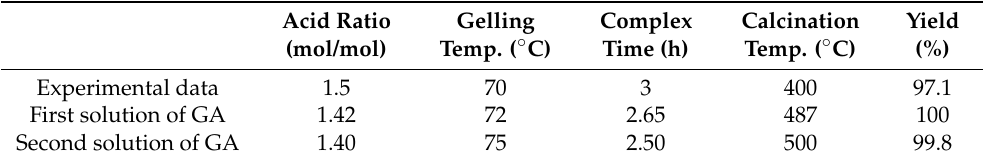
Table 3. The suggested optimum conditions with genetic algorithm for catalyst preparation via sol-gel method and experiment data.